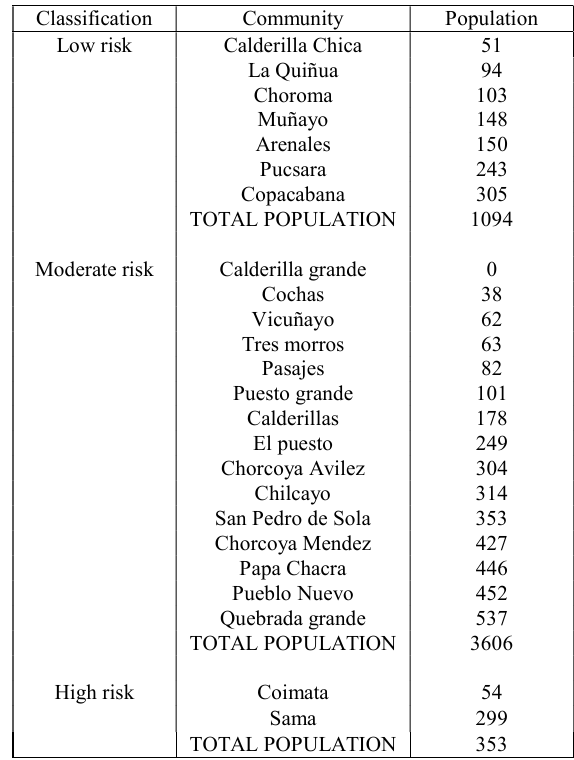
Table 9. Population of communities within each risk level areas